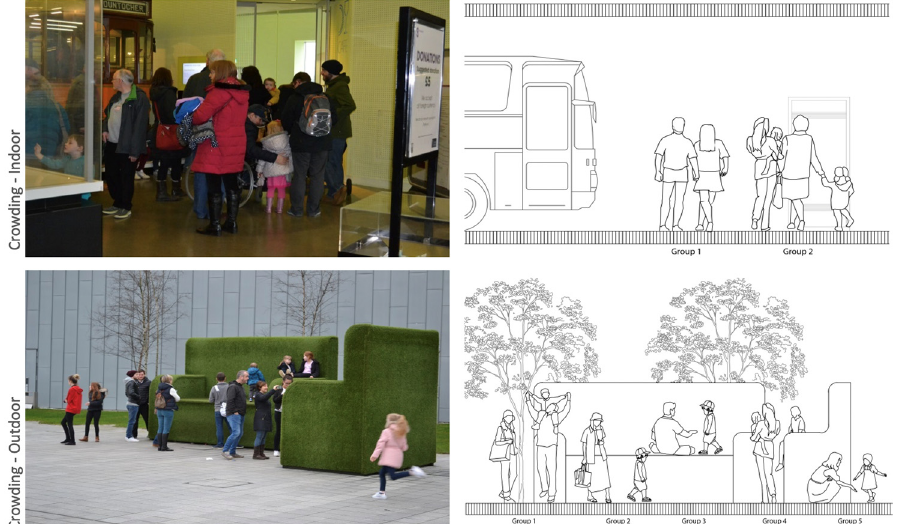
Figure 8. Crowding behavior as observed in two settings inside and outside the Riverside Museum. (Photos by A. Salama; drawing by L. MacLean)